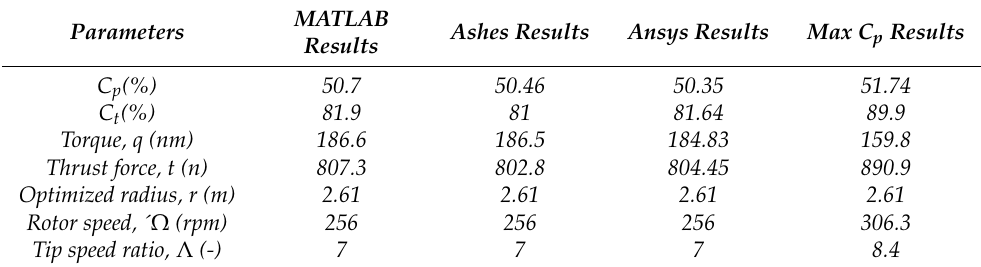
Table 4. Performance results of the designed blade at design conditions.